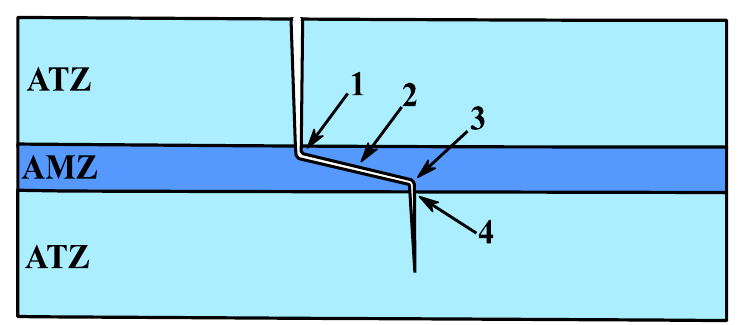
Figure 5: Scheme of stages of crack propagation in the compressive layer of ceramic laminate with strongly bonded